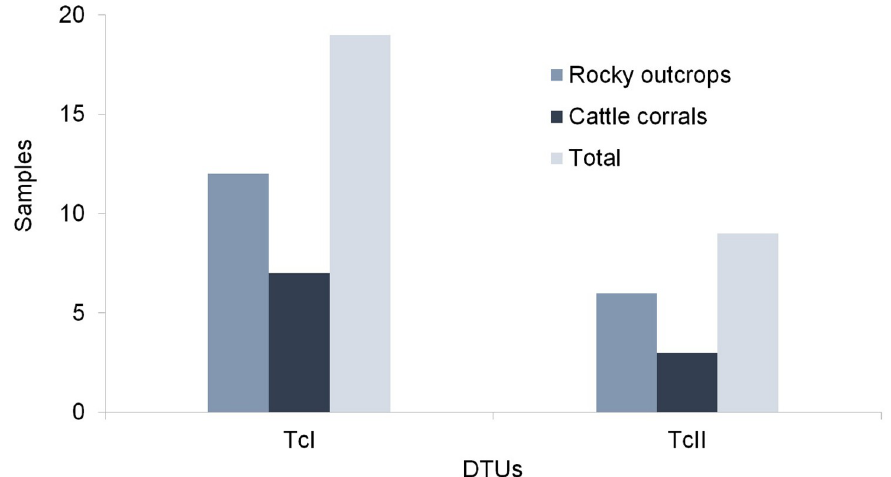
Fig 3. Trypanosoma cruzi DTUs distribution isolated of the Triatoma b . brasiliensis captured in the cattle corral (peridomestic setting) and rocky outcrops (sylvatic-d and sylvatic-c) from the Pedregulho, Ina´cio, S ã o Bernardo de Elias, and Riacho do Santo and the Batalh ã o de Engenharia de Construc¸ ã o localities in the Caico´ municipality, Rio Grande do Norte,